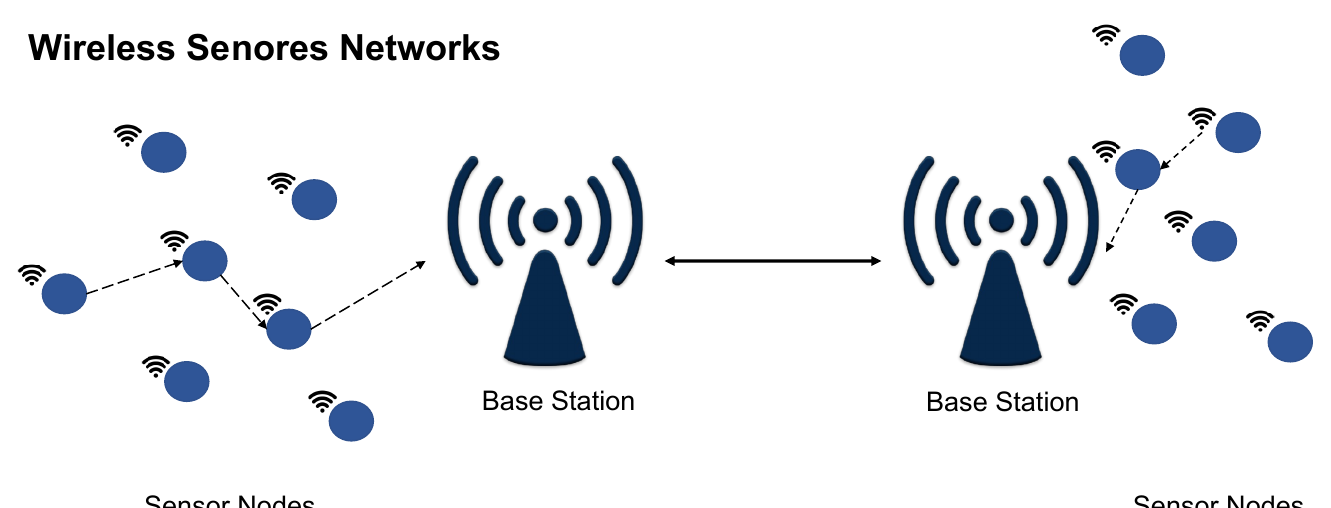
Figure 3. Wireless Sensor Network